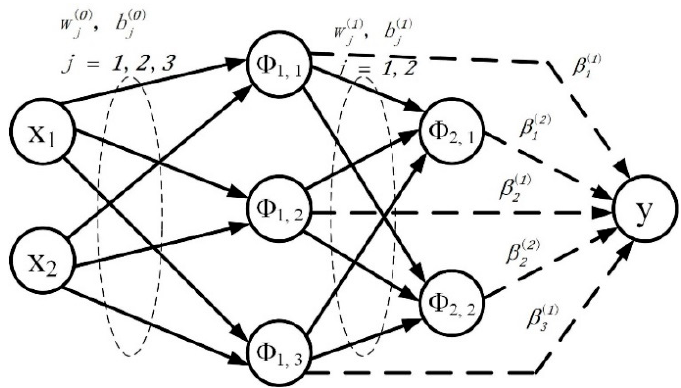
Figure 6. Typical deep stochastic configuration network (DSCN) diagram.